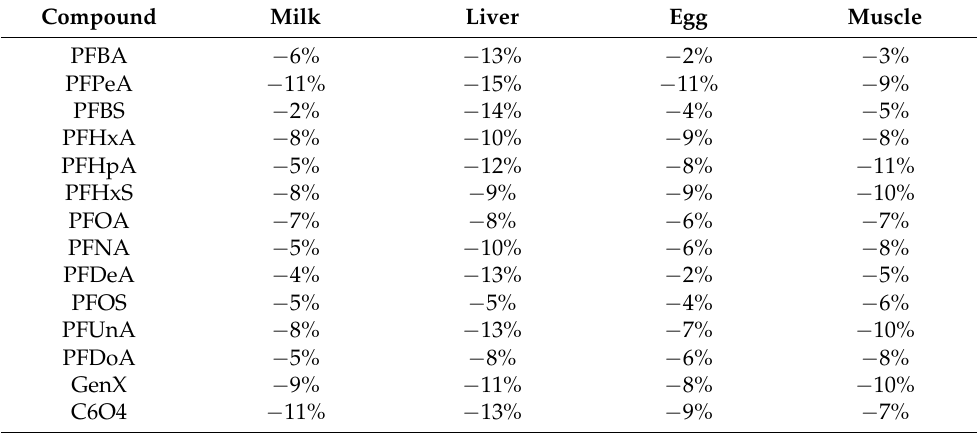
Table 5. Matrix effect expressed as the percentage difference of response (slope of the calibration curves) from the standard in the matrix extract and standard in solvent.